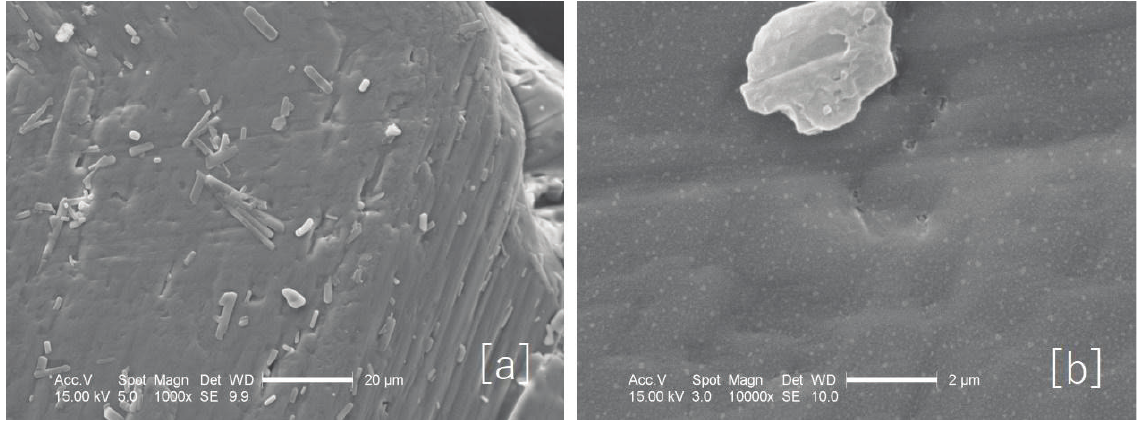
Fig. 2 – Surface of the SO grain, BSE, magnification: a) 1000x, b) 10000x Fig. 2 Surface of the SO grain, BSE, magnification: a) 1000x, b)